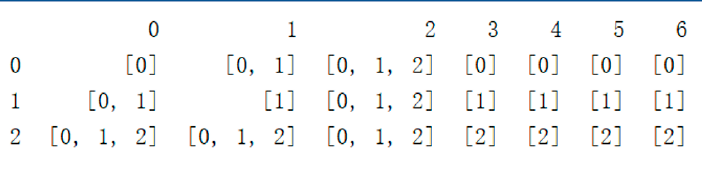
Figure 5. Upper half (running result of Python).